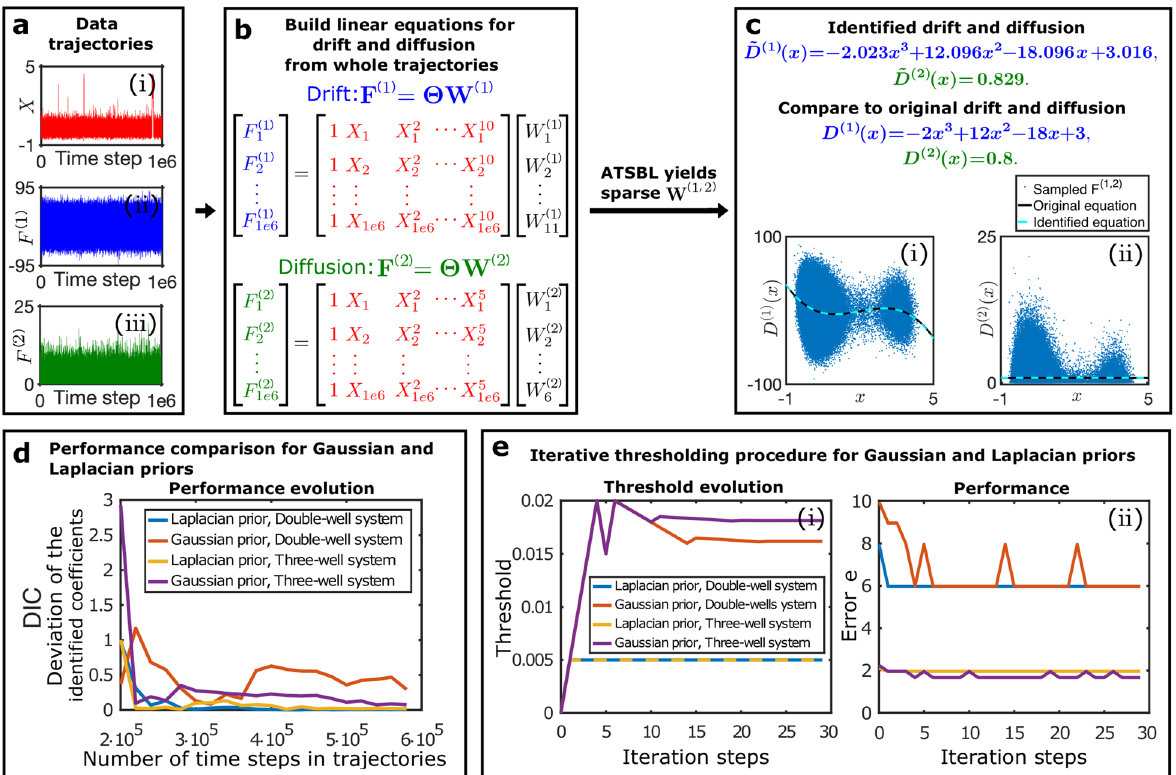
Figure 1. Data-driven discovery of a one-dimensional SDE with automatic threshold sparse Bayesian learning (ATSBL). ( a-i ) Trajectory of a particle undergoing overdamped diffusive motion in a double-well potential ( 10 6 time steps). ( a-ii , a-II ) Values of the F ( 1 ) and F ( 2 ) generated with discrete differences from the same trajectory. ( b ) The library matrix (cid:31) is constructed by evaluating a given set of functions for all values of the trajectory. Thereby,